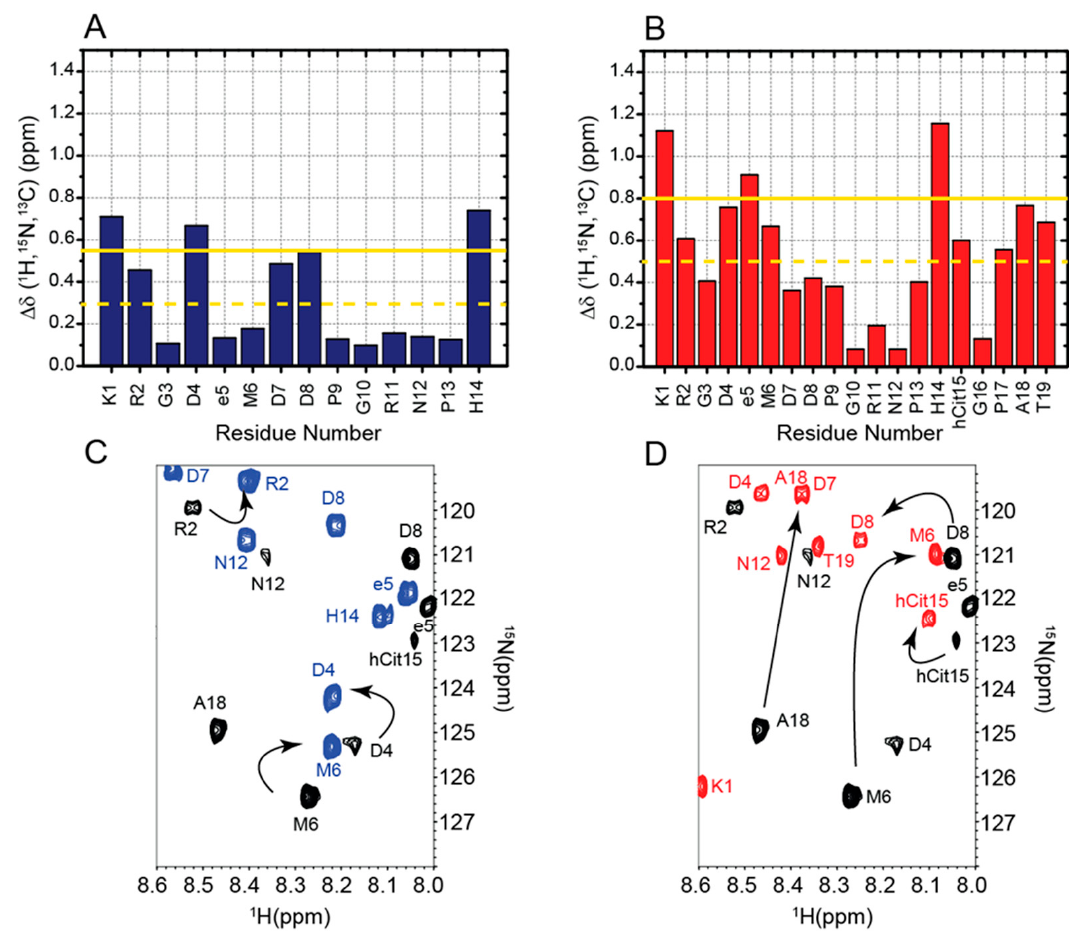
Figure 4. Structural effects of the chemical modifications in RGDechi1-14 and ψ RGDechi. ( A , B ) Plot of combined 1H, 13C, and 15N chemical shifts perturbation as a function of the residue number of RGDechi1-14 and ψ RGDechi, respectively. The CSP analysis for both peptides was performed using as reference the chemical shifts reported for the wild-type RGDechi in a previous publication (see main text). The yellow line indicates the average CSP (CSPavg), whereas the yellow dashed line reports the CSPavg + SD (standard deviation). ( C , D ) Overlay of the 1H-15N HSQC experiments of RGDechi1-14 (blue) and ψ RGDechi (red) with the spectrum recorded for the wild-type RGDechi.